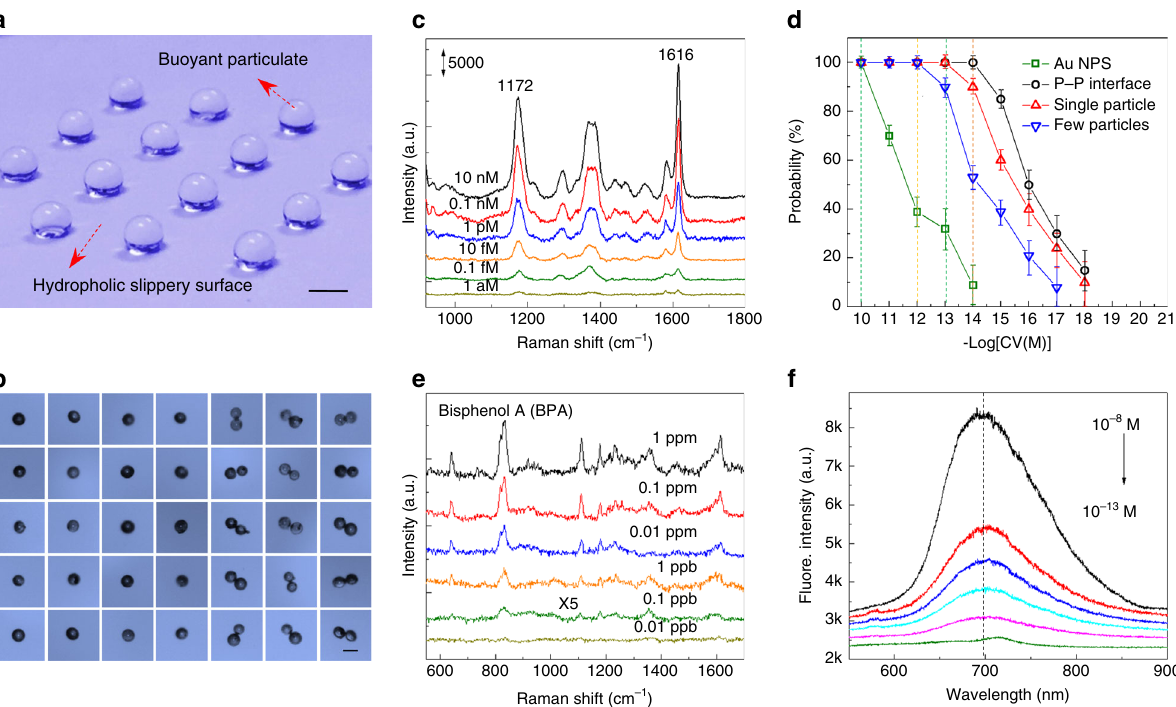
Fig. 4 The slippery surface, the plasmonic sensing properties and applications. a The droplet with a certain volume on superhydrophobic slippery surface to sort single or dimer particles. The scale bar is 0.5 mm. b The optical images of sorting single and dimer buoyant particulate on the top of droplet. The scale bar is 50 μ m. c SERS spectra of CV molecules obtained from aqueous solutions at different concentrations from 10 nM to 1 aM. d Probability of obtaining observable SERS signals at different concentrations for four types of SERS detection protocols, i.e., a droplet containing the Au NPs dries on PTFE porous surface and buoyant-particulate suspended droplet on slippery surface with single, dimer, and few particles. e The current SRES strategy for the portable detection of persistent organic pollutants (POPs). f Fluorescent spectroscopes and limit of detection of CV probe molecule using the present buoyant particulate